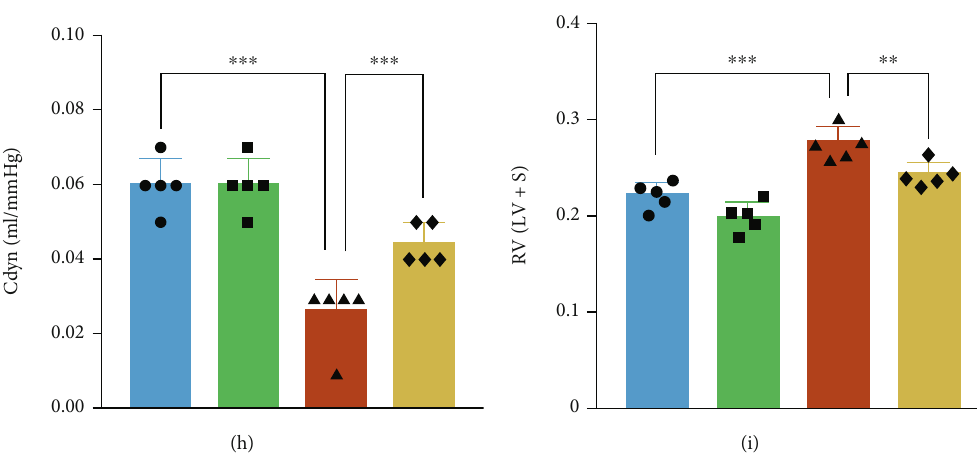
Figure 5: MVs improve lung development and function in the IA-LPS BPD model. (a) Representative lung sections stained with H&E on PN14, scalebar = 200 μ m. (b) Quanti fi cation of MLI ( N = 5 , ANOVA, ∗∗∗ P < 0 : 001 ). (c) Quanti fi cation of RAC ( N = 5 , ANOVA, ∗∗∗ P < 0 : 001 ). (d) Comparison of pups ’ weight among four groups ( N = 5 , ANOVA). (e) Representative immuno fl uorescence images of vWF staining in the lung on PN14 in each group, scalebar = 100 μ m. (f) Quanti fi cation of vWF-positive vessels ( < 100 μ m) ( N = 5 , ANOVA, NS: not signi fi cant, ∗∗∗ P < 0 : 001 ). (g) Lung resistance (LR) and (h) dynamic compliance (Cdyn) were determined from anesthetized and ventilated pups ( N = 5 , ANOVA, ∗∗∗ P < 0 : 001 ). (i) RV/LV + S to measure RVH ( N = 5 , ANOVA, ∗∗∗ P < 0 : 001